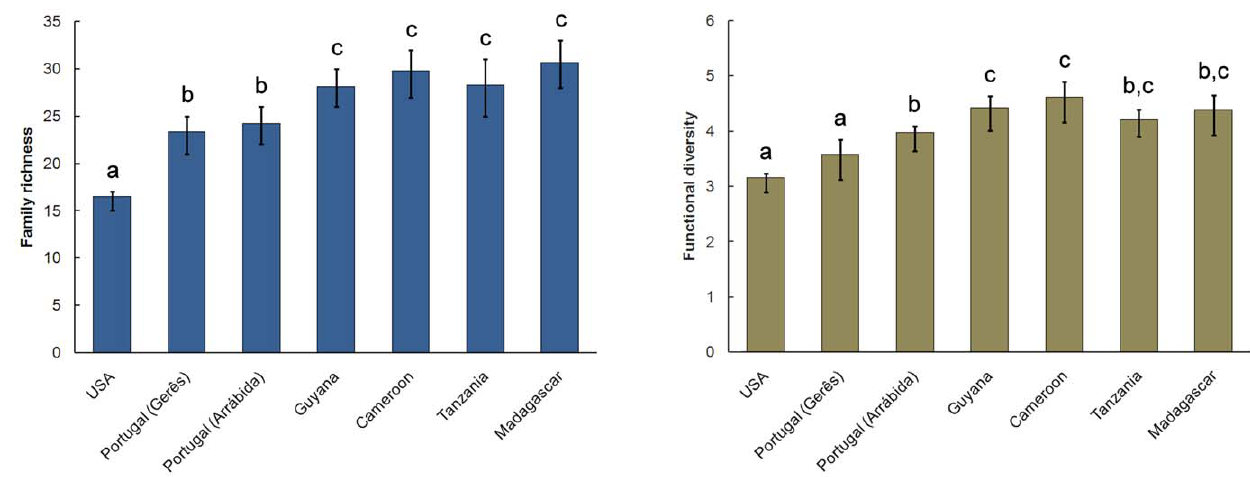
Figure 4. Average family richness and functional diversity per site (after resampling for 1000 individuals). Letters represent statistically different (at a , 0.05) groups as determined by the resampling